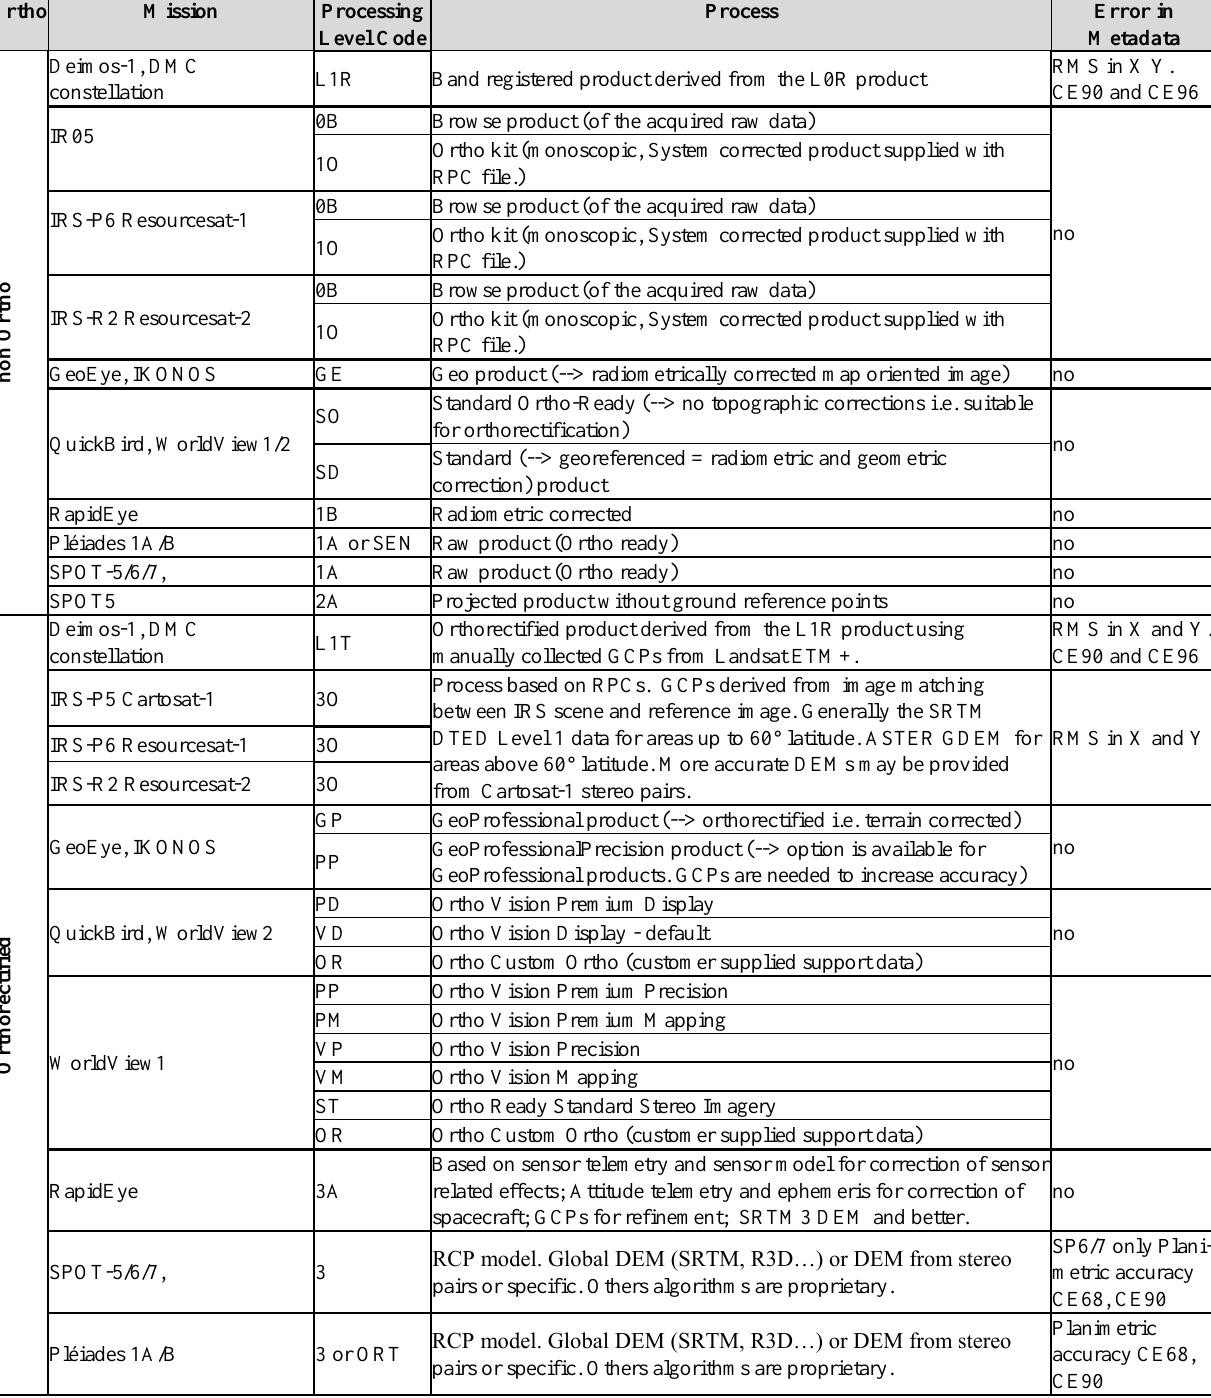
Table 1. Definitions of Processing Level Code, processes and geometric errors across the